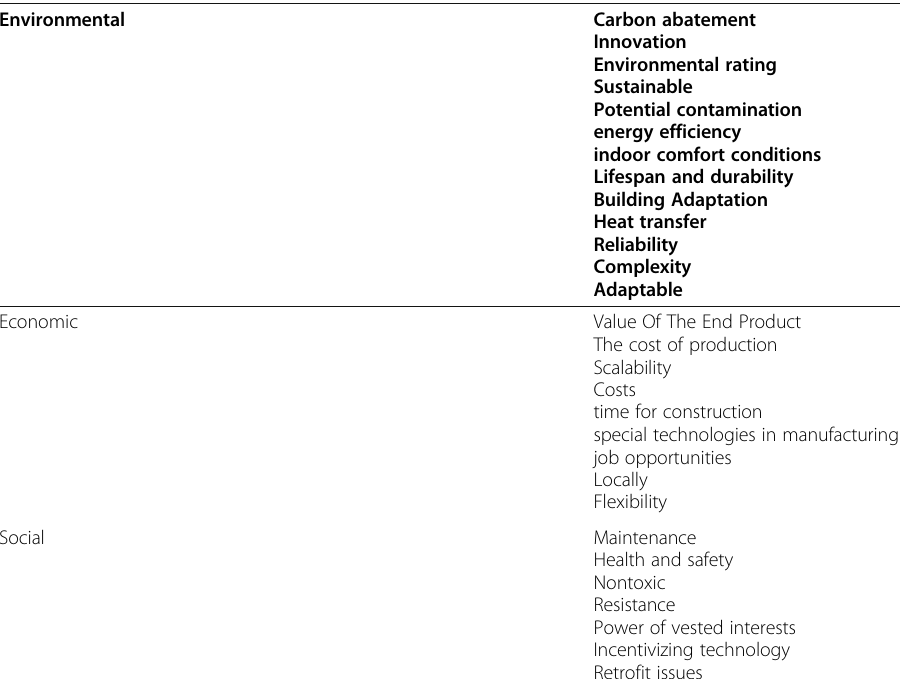
Table 7 Issues raised Environmental Carbon abatement